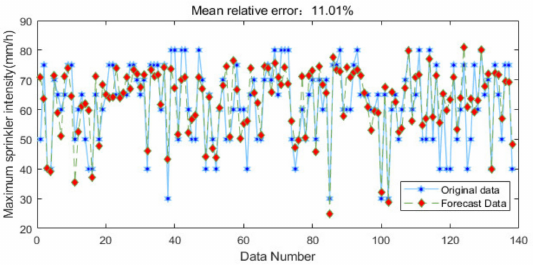
Figure 8. The smoothness parameter of the RBF neural network is 1.14.